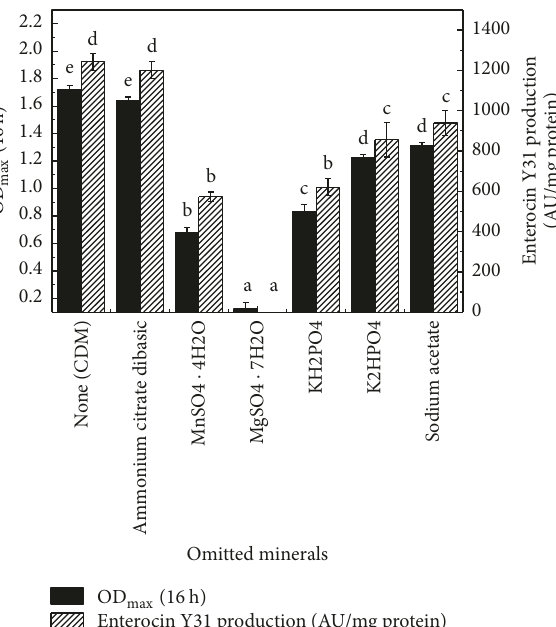
Figure 4: Effect of individually omitting each a mineral on the growth of Enterococcus faecium Y31 and Enterocin Y31 production. Means not sharing a common superscript letter are significantly different from each other ( 𝑃 < 0.05 ).